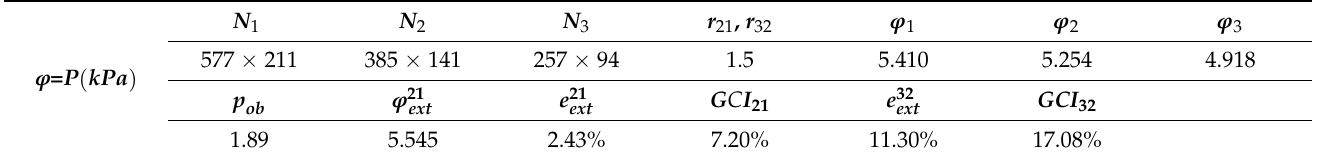
Table 2. The results of grid convergency calculations.